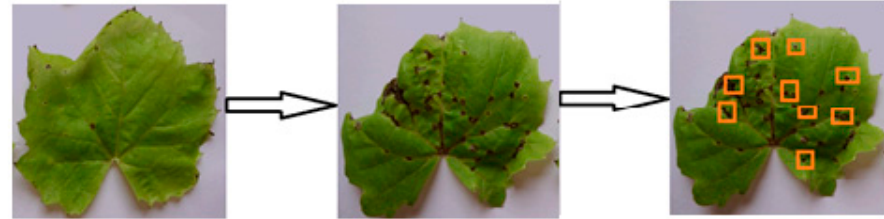
Figure 4. Flowchart of the ODS algorithm.